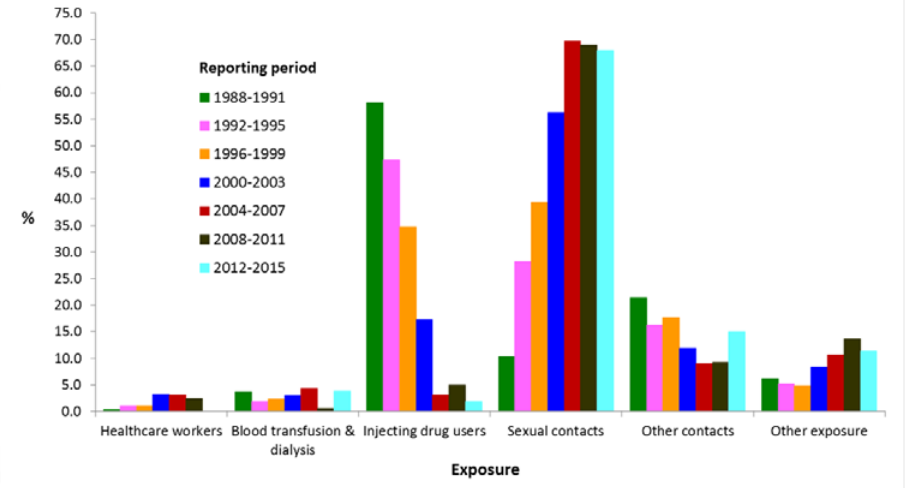
Figure 4: Assumed exposure of acute hepatitis B virus infection by notification period, Switzerland, 1988–2015 (100% = total known exposures by period, includ- ing multiple exposures)